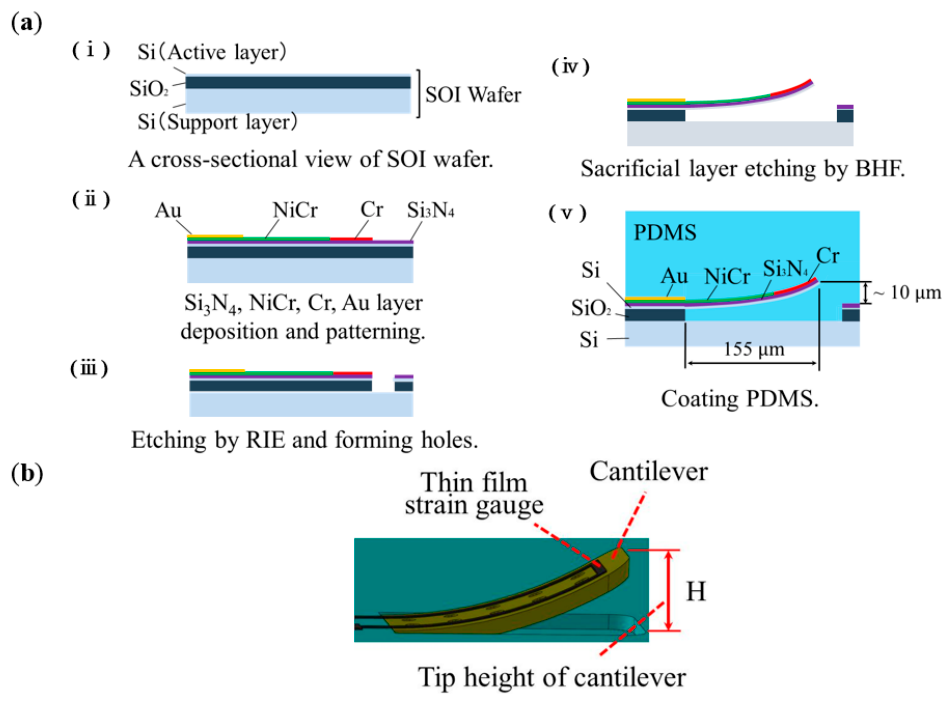
Figure 4. ( a ) Cross-sectional view of sensor fabrication method, and ( b ) schematic illustration of cantilever.